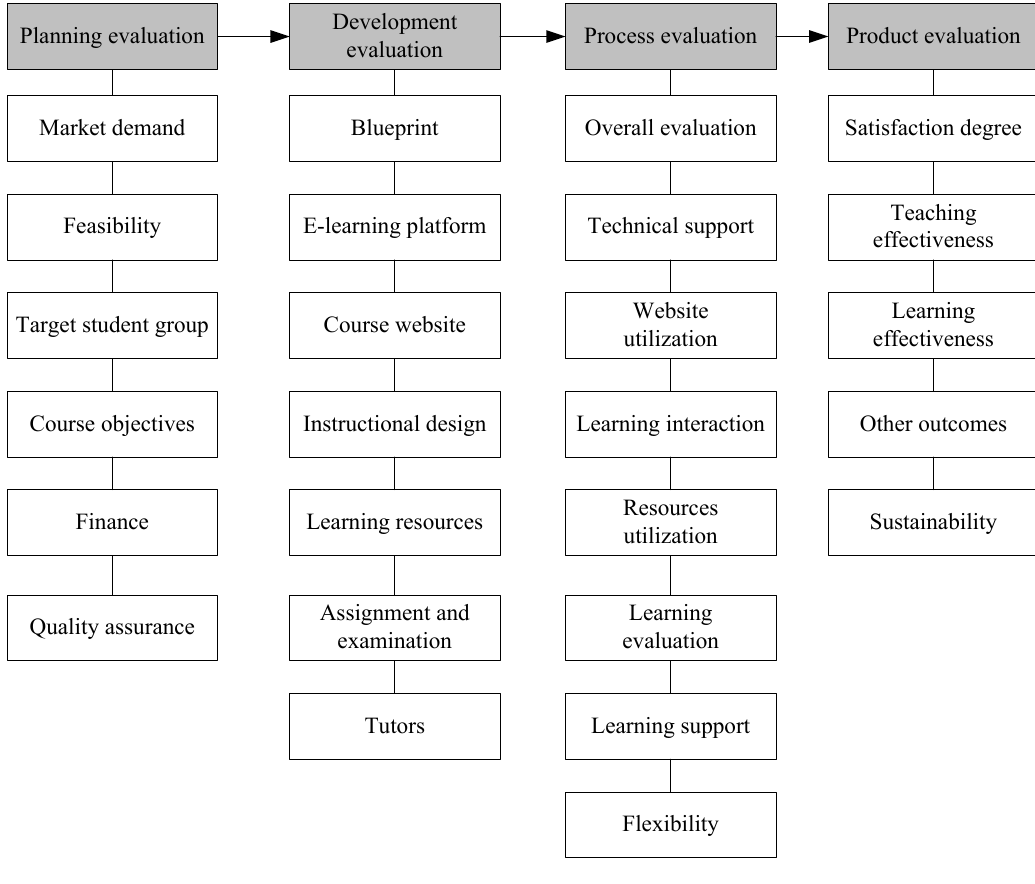
Figure 1 . The PDPP evaluation model for e-learning